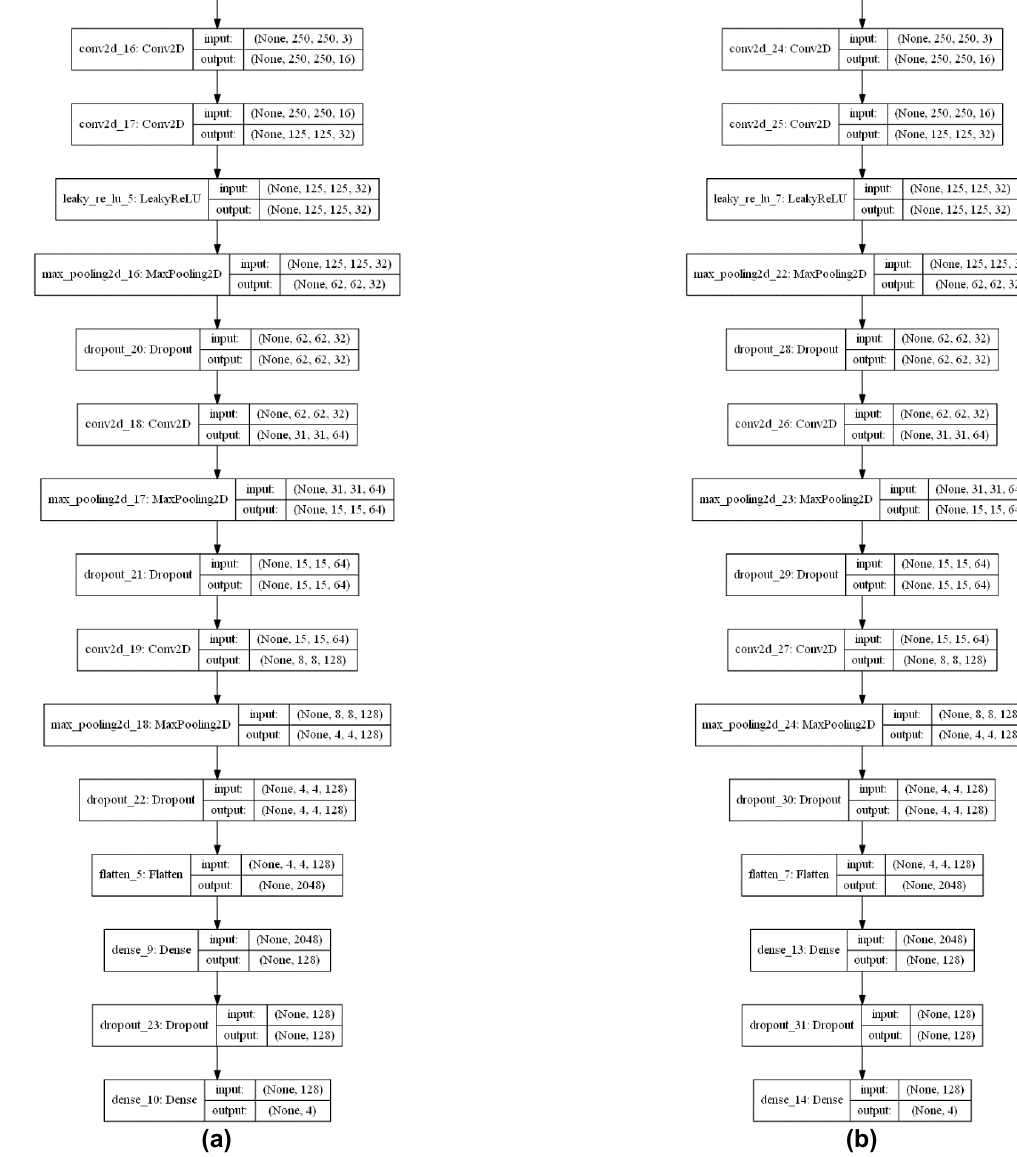
Figure 6(a) The Architecture of model (1) of AiCNNs from Table 2. This is a normal CNN model that doesn’t utilize Data Augmentation . (b) The Architecture of model (2) of AiCNNs from Table 2. This is a normal CNN model